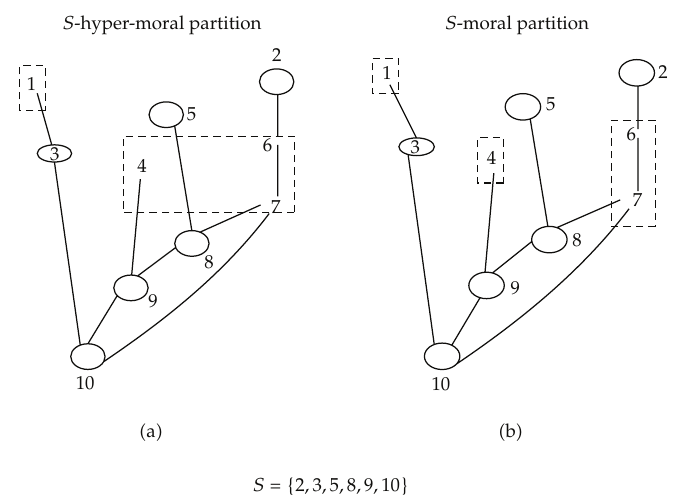
Figure 6: (cid:5) a (cid:6) P hm The S -hypermoral partition. (cid:5) b (cid:6) P m S